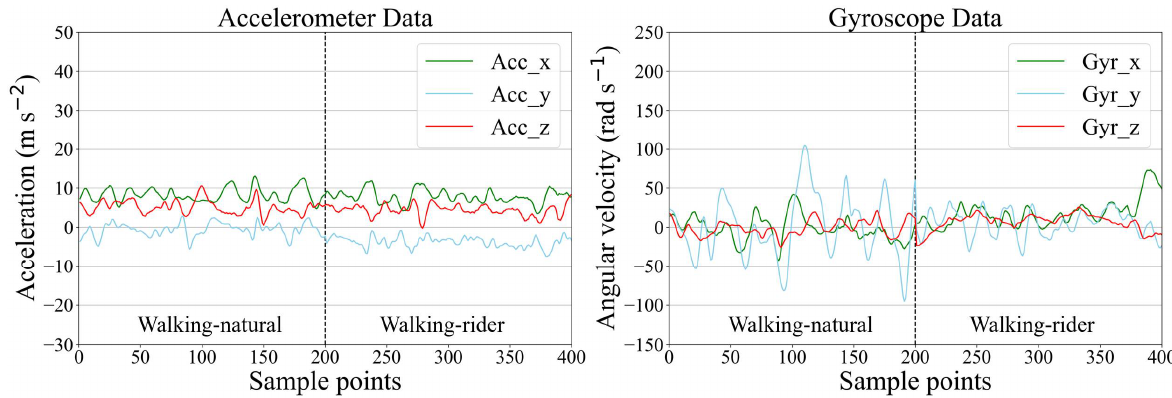
Figure 8. Example of accelerometer and gyroscope data for walking-natural and walking-rider.